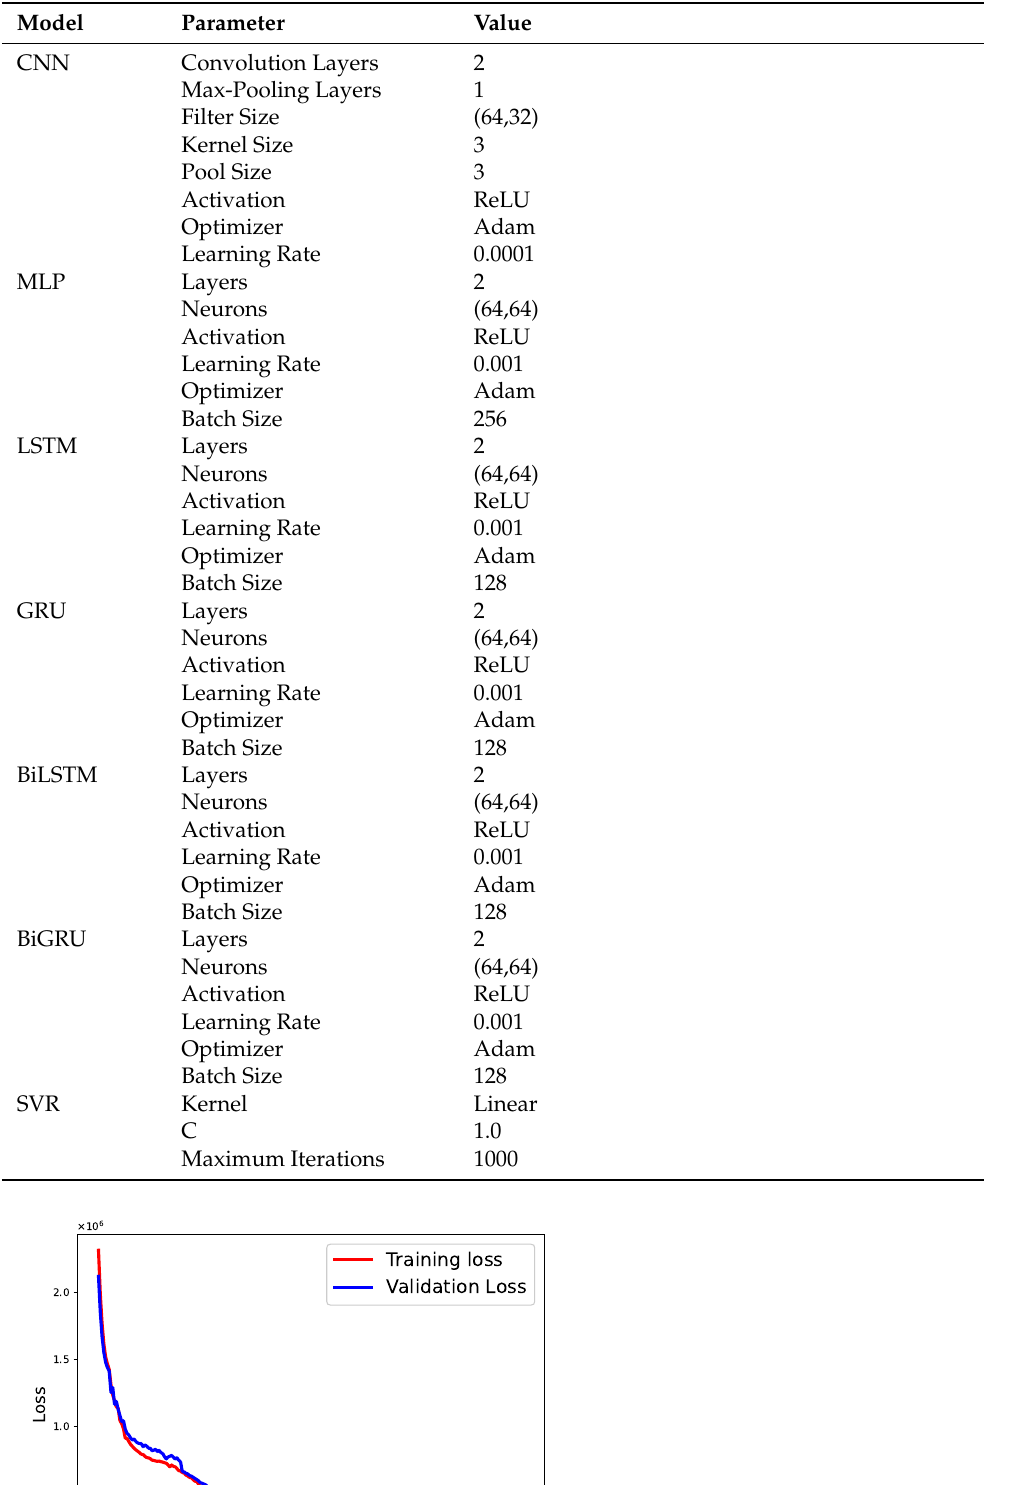
Table 2. The optimal parameter settings of the baseline techniques.